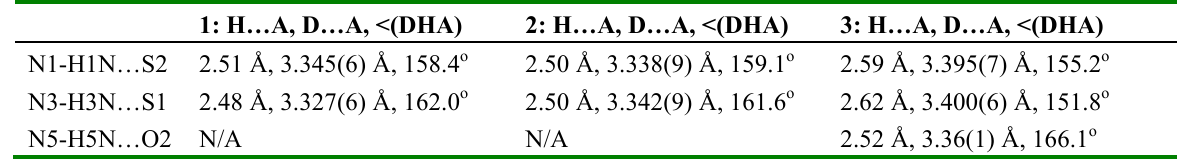
Table 2. Intermolecular hydrogen bonds documenting the thioamide {…H-N-C=S} 2 dimer formation and NO -H… donor (D) … acceptor (A) interactions in 3 2